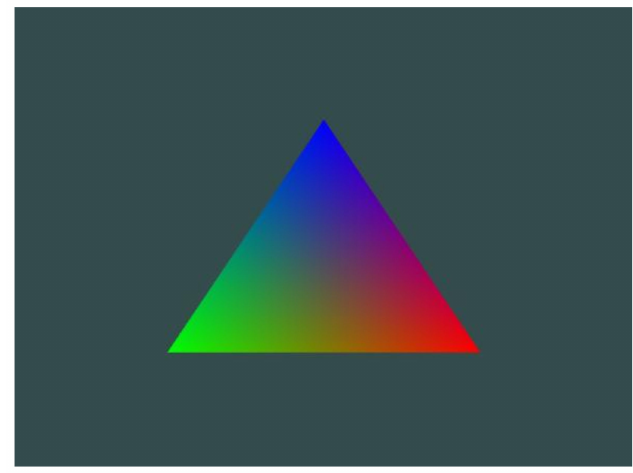
Figure 24. Example of vertex shading.